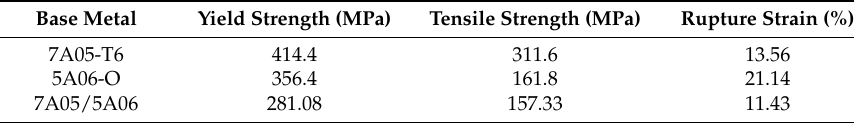
Figure 5. Micro-hardness across the weld. Table 2. Mechanical properties of the 7A05BM, 5A06BM and weld joint.